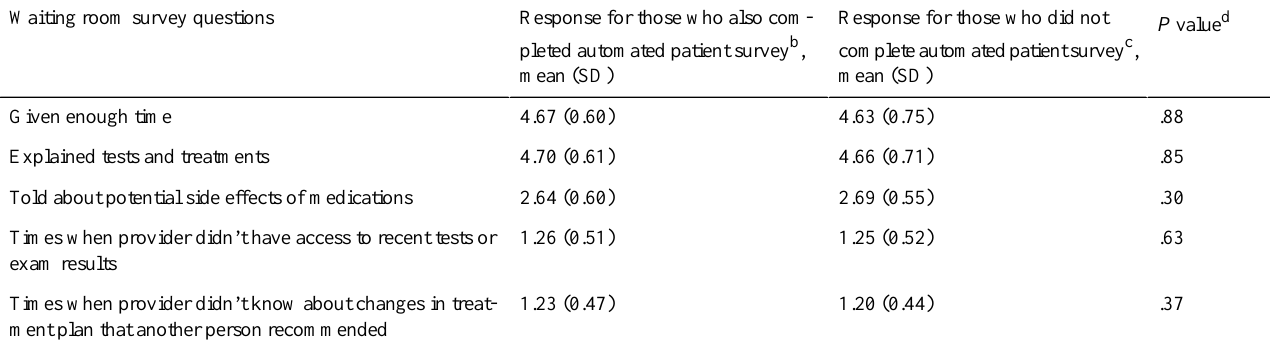
Table 2. Comparison of waiting room survey responses between those who completed the automated patient survey to those who did not a .